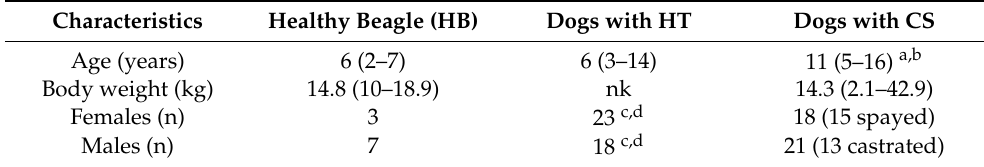
Table 1. General characteristics (median and range) of healthy beagle (HB) dogs, dogs with hypothy- roidism (HT), and dogs with Cushing’s syndrome